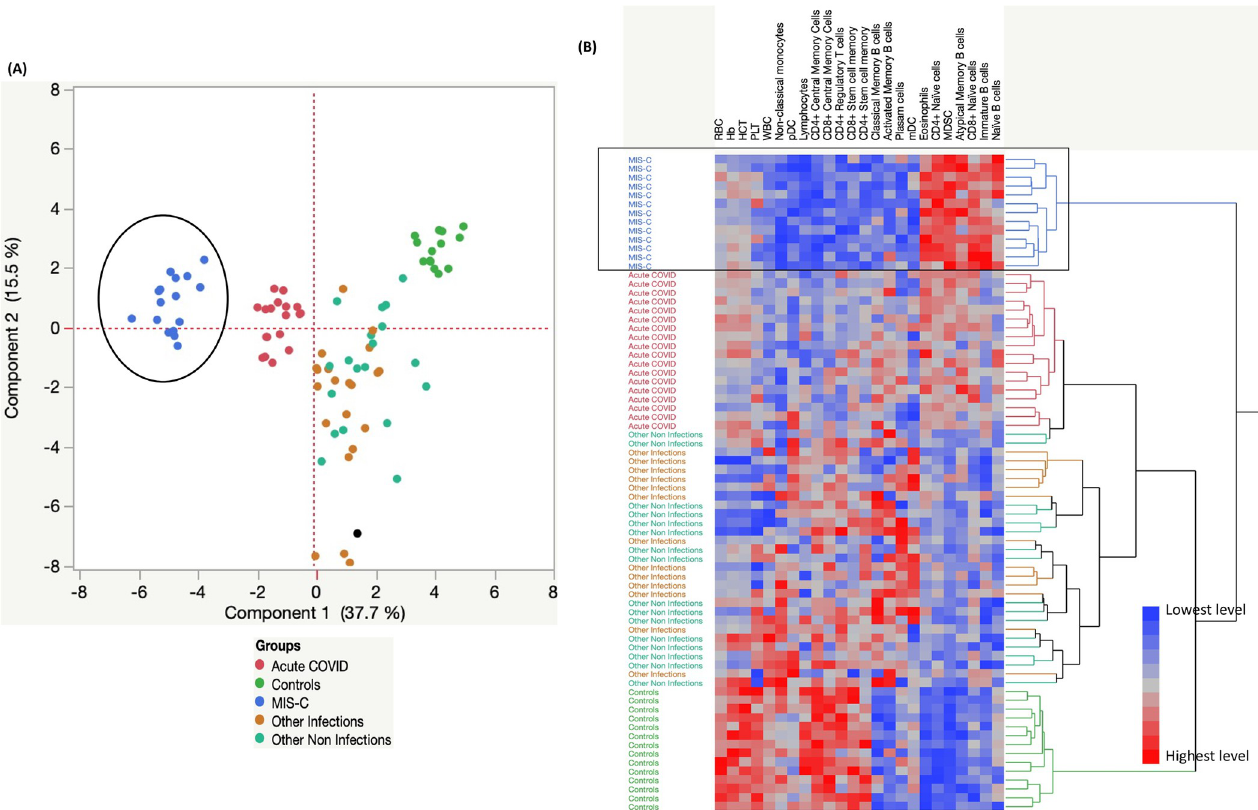
Fig 6. Hematology and Cellular subset markers can strongly discriminate MIS-C from acute COVID-19 and other infections, other non-infections and control children. (A). PCA (Principal component analysis) plot computing normalized cellular subsets after excluding those factors with commonalities as low as 0.5 we used hematology parameters like RBC, Hb, HCT, PLT, WBC, lymphocytes and eosinophils, cellular subsets absolute counts of CD4 + and CD8 + Na ï ve, central memory, stem cell memory, Regulatory T cells, Na ï ve B cells, Immature B cells, Classical B cells, Activated, Atypical memory B cells, plasma cells, pDC, mDC, MDSC and non-classical monocytes in a combination of five different experimental groups first MIS-C (Colored in blue) vs acute COVID-19 (Colored in red) vs other infections (Colored in brown) vs other non-infections (Colored in light green) and controls (Colored in dark green). The PCA shows the two principal components of variation, accounting for 15.5% (x-axis) and 37.7% (y-axis). (B). Hematology and cellular subsets are illustrated according to the score denoted in the color-scale bar. Associated horizontal dendrograms denote the patient’s clustering, standing out clusters containing MIS-C (enclosed in blue), acute COVID-19 children (enclosed in red), other infections (Colored in brown), and other non-infections (enclosed in green) or controls children (enclosed in light green). On the color scale, blue color indicates lower expression and red color indicates higher